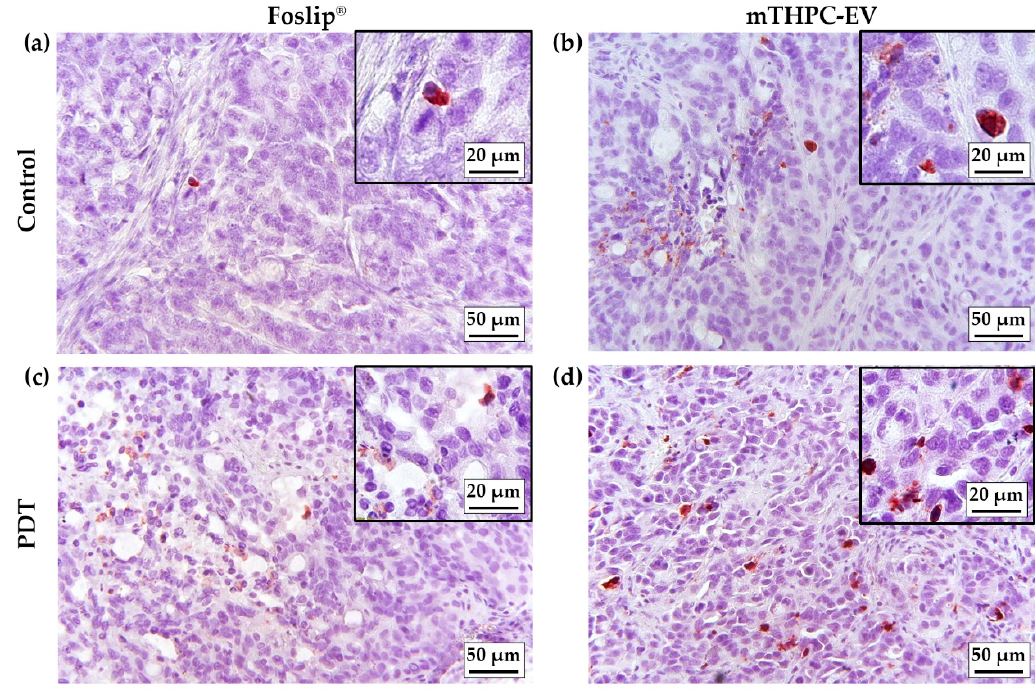
Figure 7. IHC images of active caspase-3 on para ffi n-embedded sections of HT-29 subcutaneous xenografts tumors. Images were obtained from control tumors injected with ( a ) Foslip ® and ( c ) mTHPC-EVs and from irradiated tumors injected with ( b ) Foslip ® and ( d ) mTHPC-EVs. Concentration of mTHPC was 0.30 mg / kg. Table 3. Apoptotic index calculated from the quantification of apoptotic cells. The apoptotic index was determined from at least 1000 tumor cells in each section. n = 4 mice per condition. Non-irradiated tumors were selected as the control group (drug, no light). a : p < 0.05, statistically di ff erent from